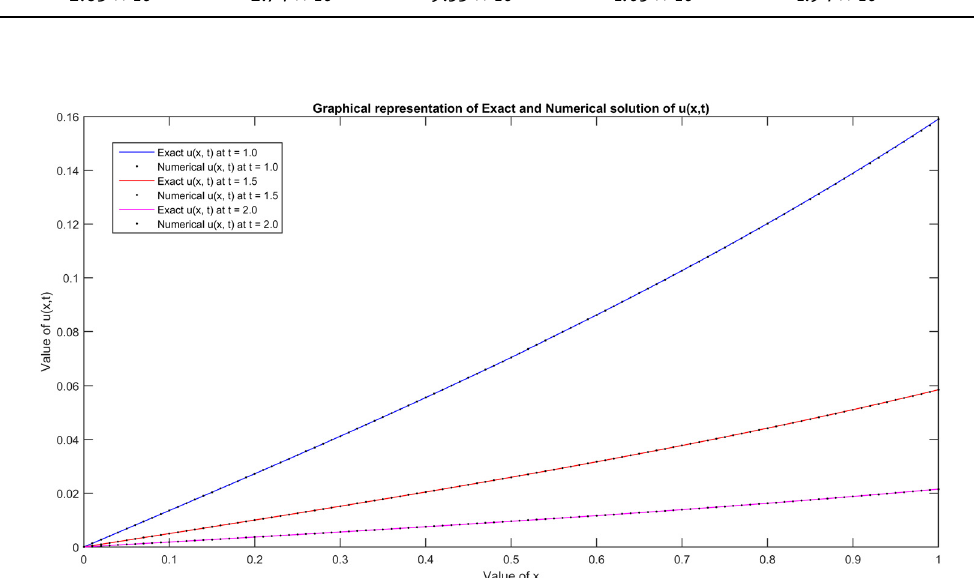
Figure 5: Comparison of ( ) u x t , at = t 1.0 , 1.5, and 2.0 for = N 101 , = α 30 , = β 10 , = t Δ 0.0001 , and = τ 0.5 using Method I regarding Example 3.